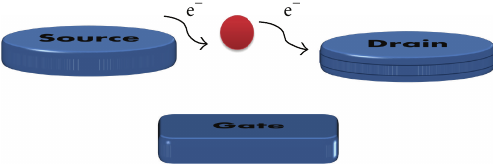
Figure 1: Basic structure of SETs schematics.